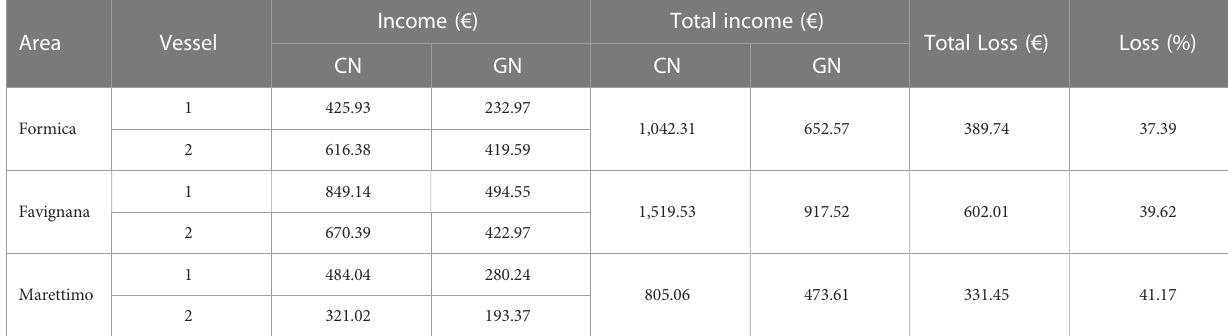
TABLE 5 Comparison of income and loss per area and vessel with standard (CN) and modi fi ed (GN) panels.